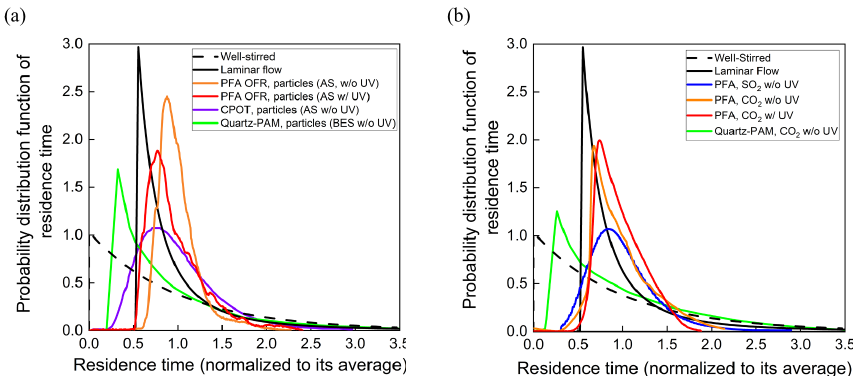
Figure 7. Residence time probability distribution functions of the PFA OFR, CPOT (Huang et al., 2017), and quartz-PAM flow tubes (Lambe et al., 2011) as a function of residence time for (a) particles and (b) gases.